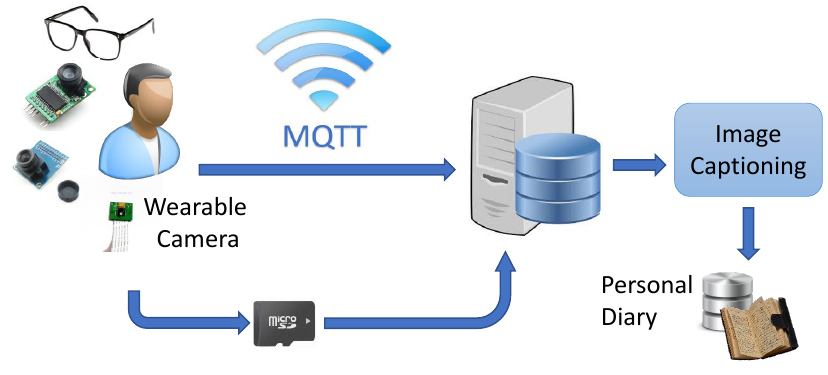
Figure 1. An overview of our lifelog generating